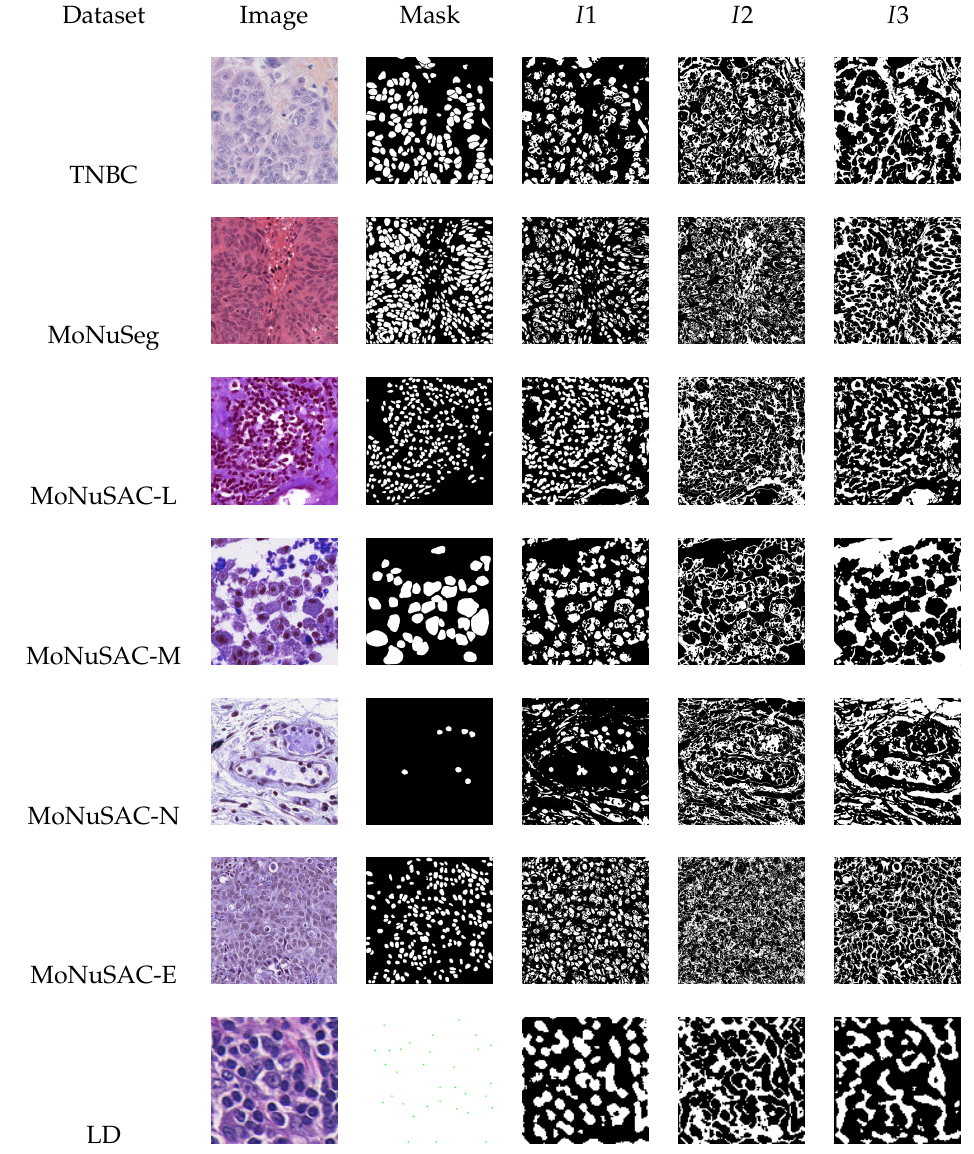
Figure 4. Sample images, ground truth masks, and segmentation maps generated after applying threshold values. threshold